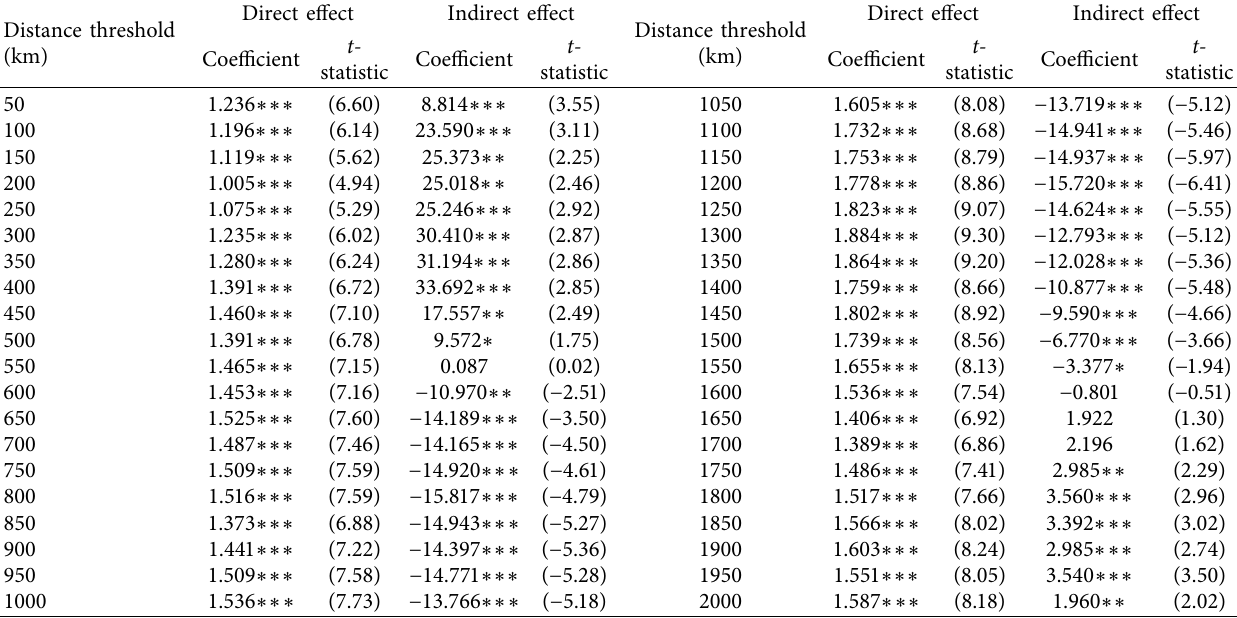
Table 10: Spatial spillover distance of the digital economy on urban innovation.